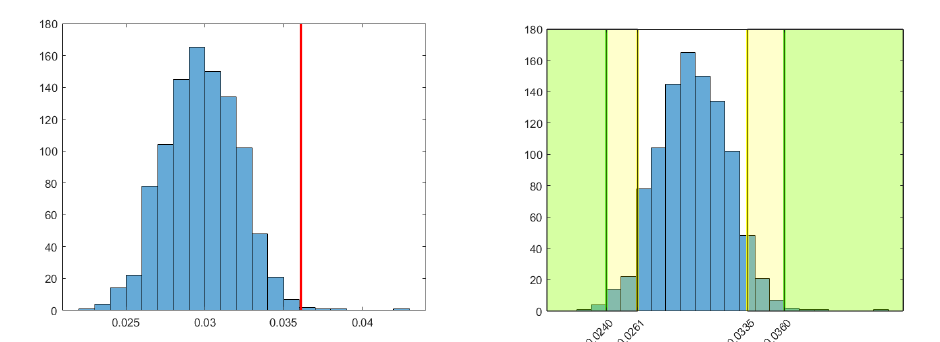
Figure A5. New empirical probability distribution of the distance between Dollar and Euro (left) and new rejection areas for α = 0.995 (green) and α = 0.95 (yellow).